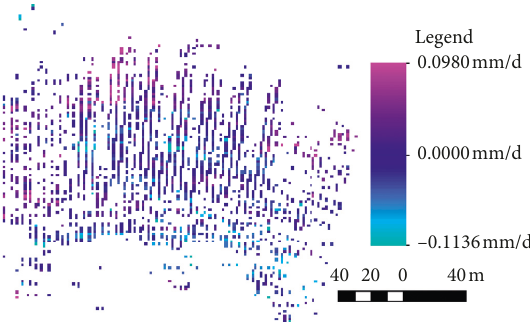
Figure 15: Average rate of deformation at each PS point (mm/d, the shade of color represents the magnitude of the rate of displacement).